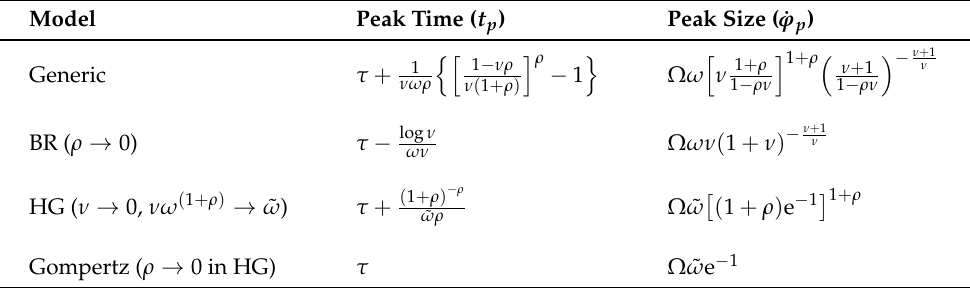
) of the generic growth curve [8] and its limiting cases. p